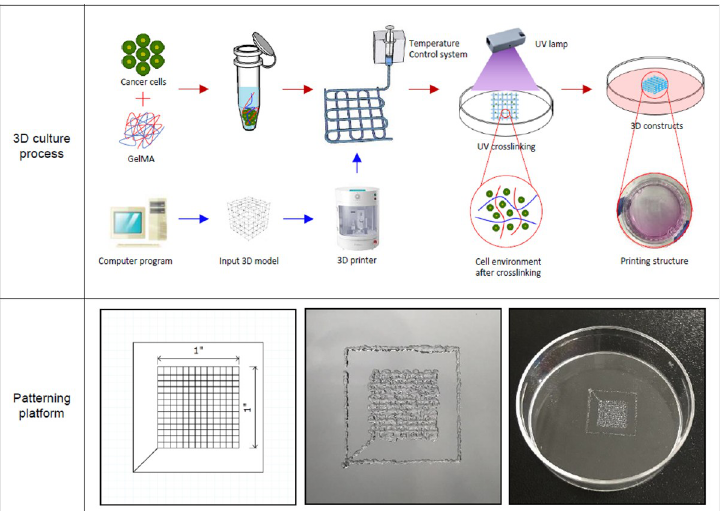
Fig 1. Cell culture using simple to complex three-dimensional bio-printing models. Schematic illustration of the 3D bio-printing process and image of the printing setup and constructs. Platform designed using a computer program. The overall size is 1 × 1 × 0.01 mm, and the order is x, y, and z-axis (left image). Top view of 3D bio-printing construct used GelMA demonstrating the porous platform of the scaffold (middle, right images).